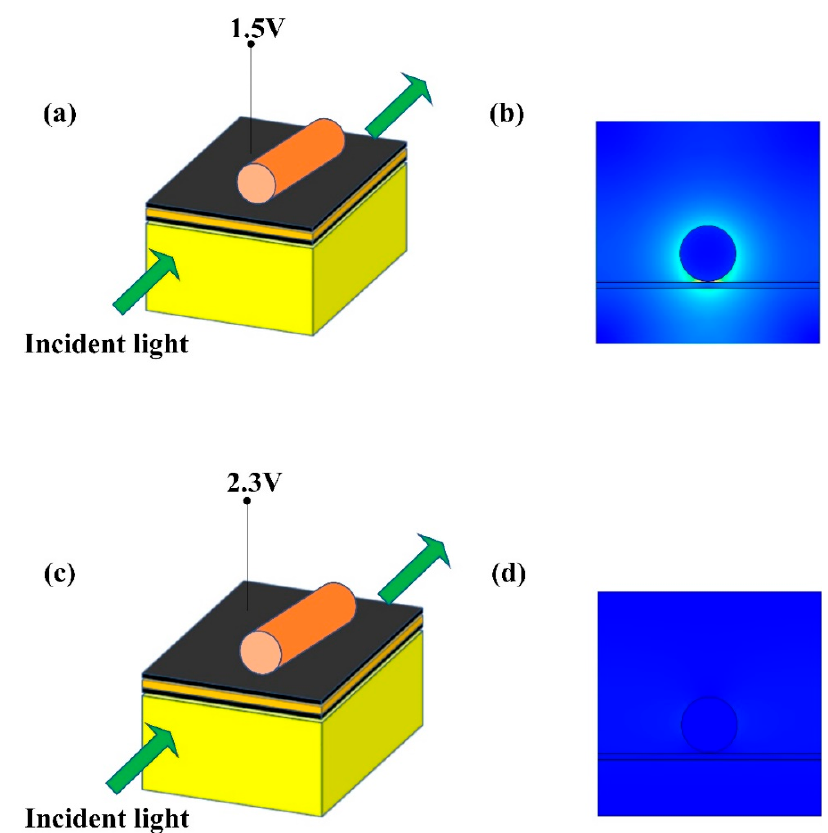
Figure 7. Working principle diagram of the presented modulator GESMBOSN: ( a ) 3D layout structure in 1.5 V ( b ) two-dimensional electric field pattern after modulation in 1.5 V. ( c ) 3D layout structure in 2.3 V ( d ) two-dimensional electric field pattern after modulation in 2.3 V.